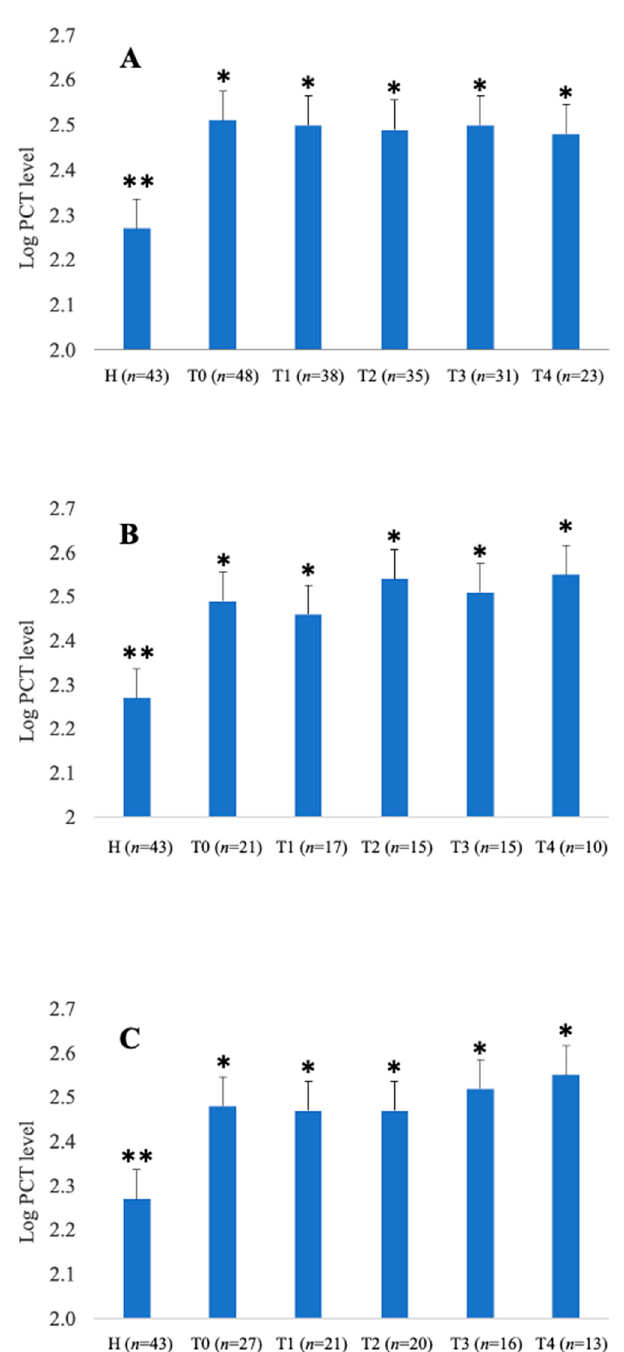
Figure 1. Logarithmic values of plasma PCT concentrations in healthy ( H ) and total colic horses ( A ), SIRS-positive colic horses ( B ), and SIRS-negative horses ( C ) at admission time (T0), then 24 (T1), 48 (T2), 72 (T3) and 96 (T4) hours after admission. The different upper-case symbols above the bar charts denote a significant difference from healthy group (** ≠ *: p < 0.05).